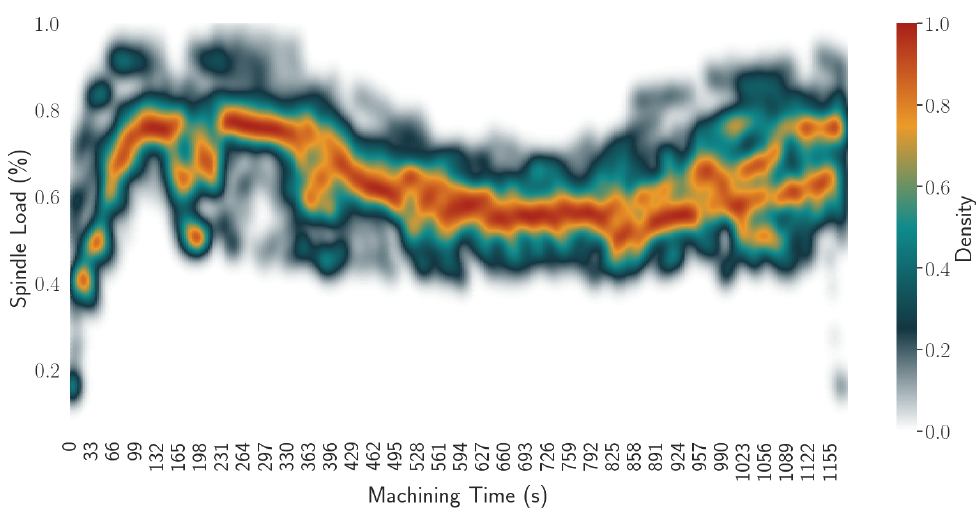
Figure 6. Spindle load probability density estimation on time bins of 3 s for program 1543, tool 6040 and machine T5-1 represented as a heat map. Algorithm 2: Computation of KDEs for each time